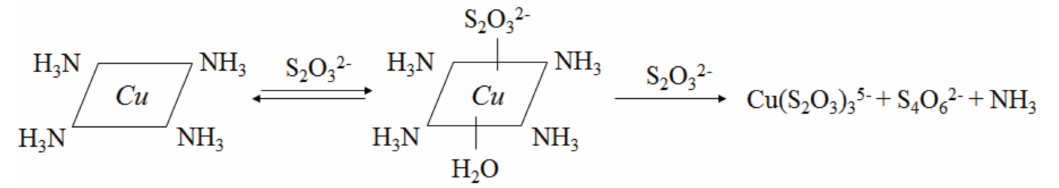
Figure 3. Oxidation of thiosulfate by Cu(II) involving the formation of Cu(NH 3 ) 4 S 2 O 3